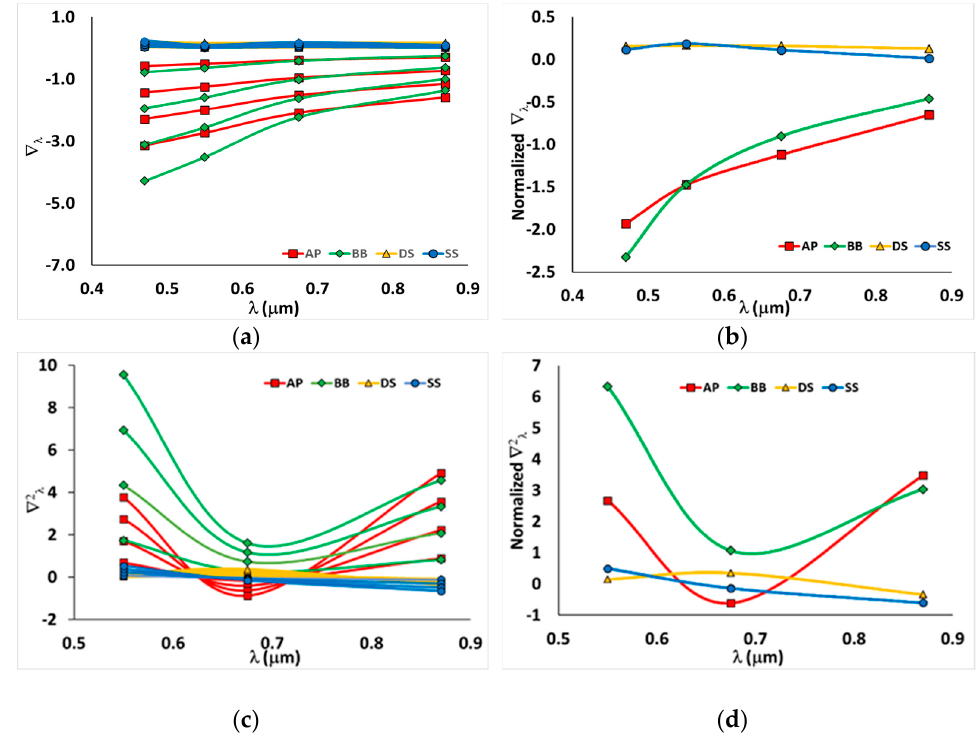
Figure 2. The first and second-order derivatives before ( a , c ) and after normalization ( b , d ) of 4 dif- ferent aerosol constituents: anthropogenic pollutant (AP), biomass burning (BB), dust (DS), and sea salt